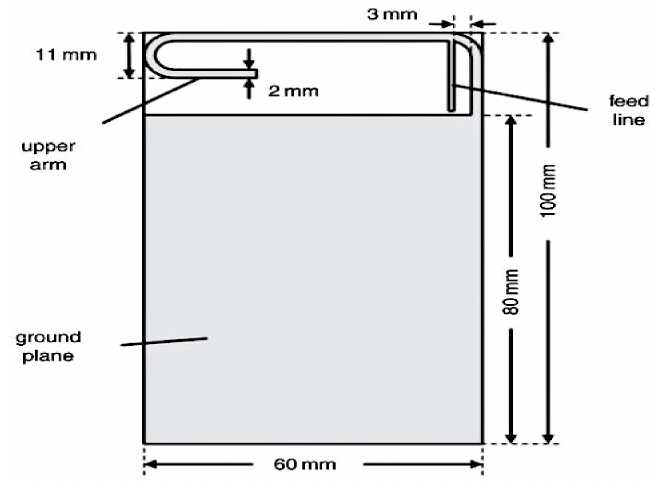
Figure 6. Planar inverted-F antenna (PIFA) [22].